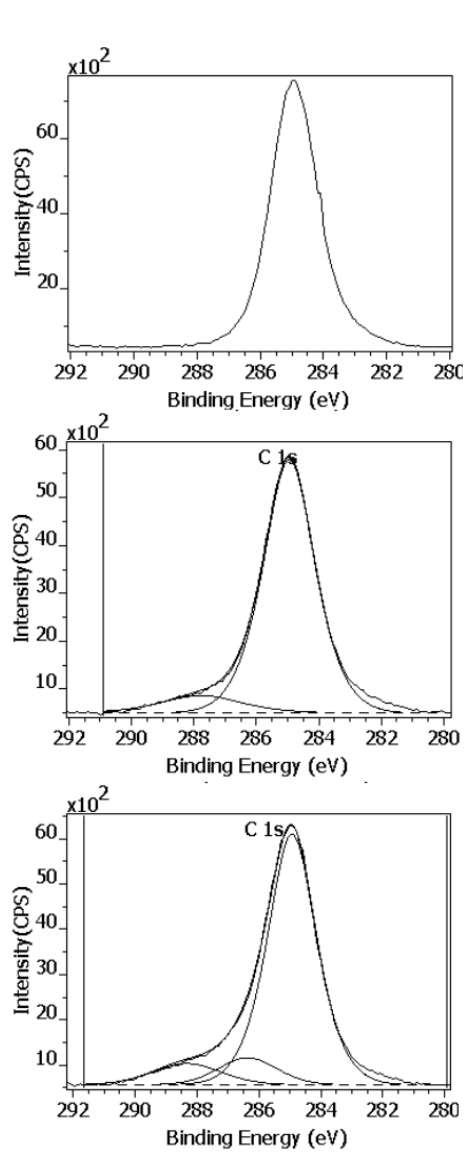
Figure 2: Decomposition of the C1s peak of polypropylene untreated (top) and atmospheric plasma-treated in nitrogen (middle) and in air (bottom).